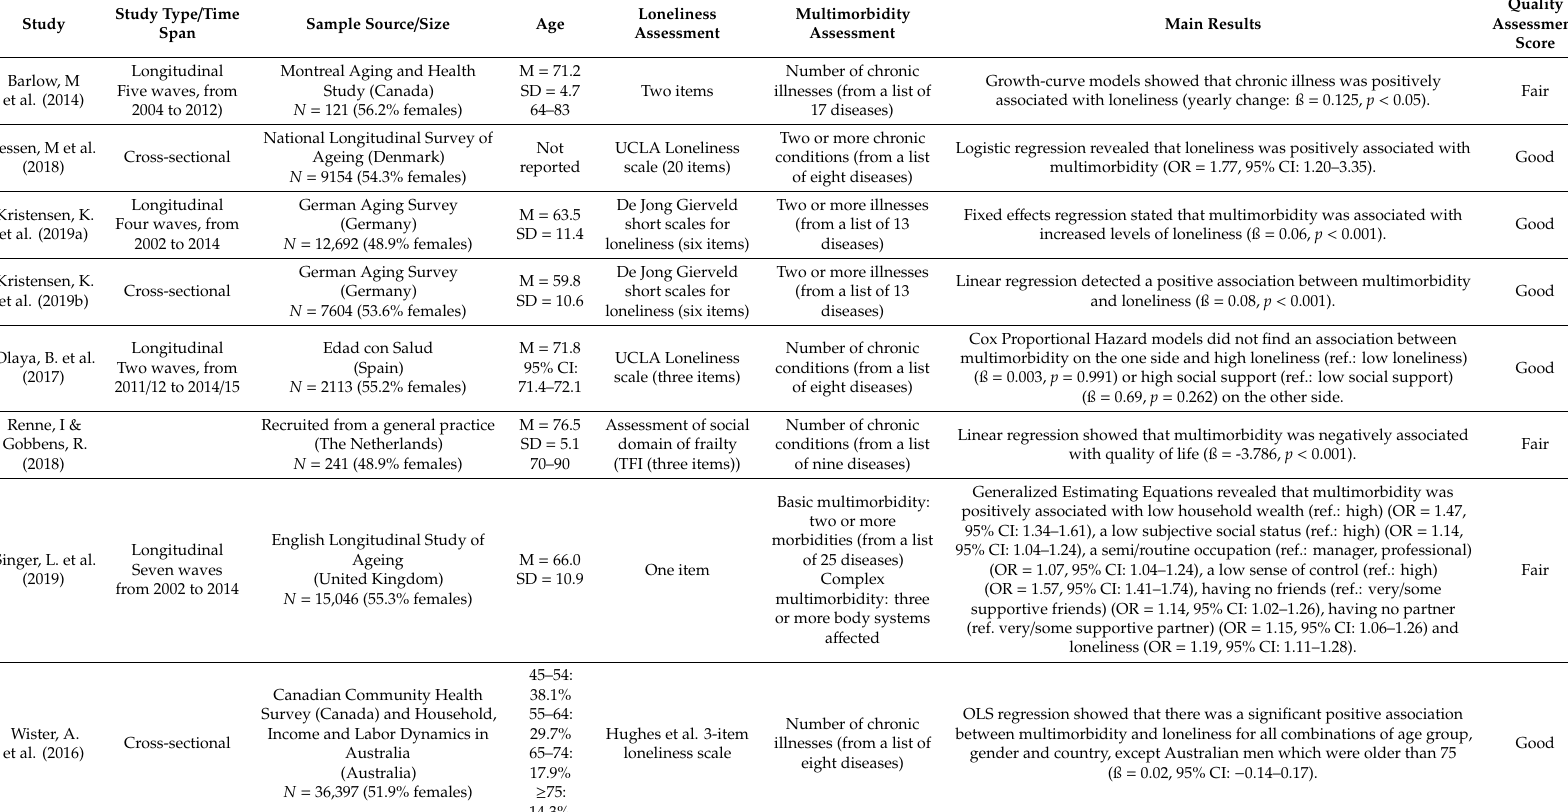
Table 2. Extracted